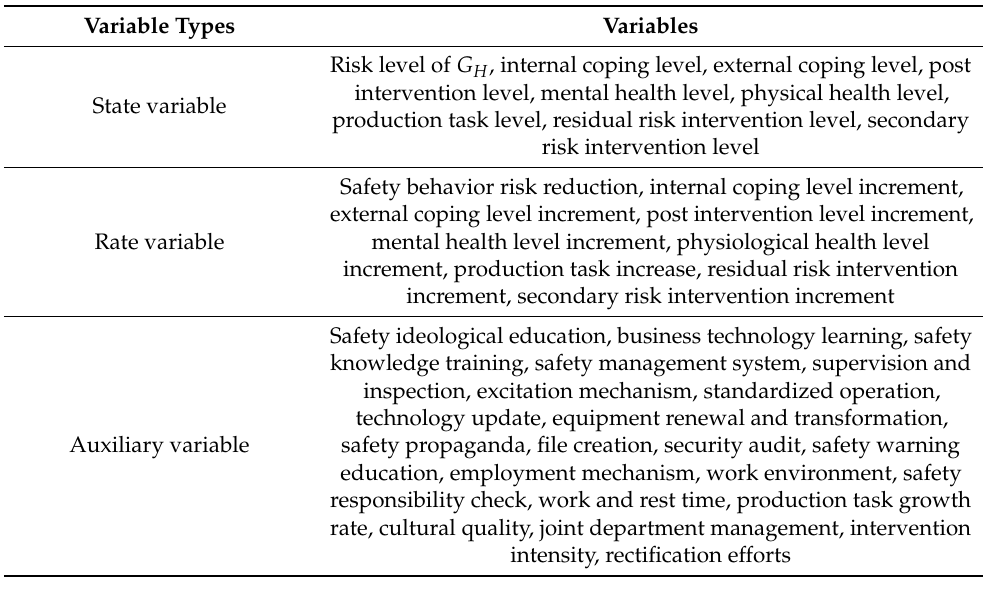
Table 3. Set of system dynamics variables of grid G H .